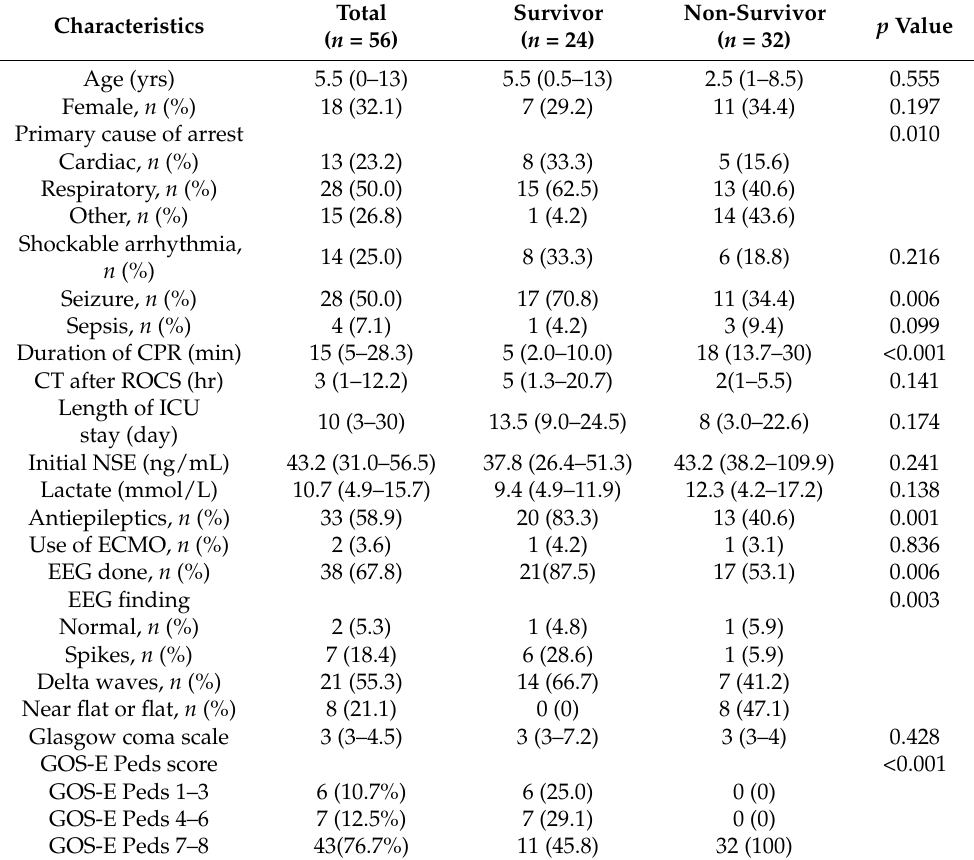
Figure 2. The flowchart of the patients. As described in Table 1, 38 patients were male, and 18 were female. There was no statistical difference between survivors and non-survivors. The median age was 5.5 years (IQR 0–13). Although there was not a significant difference between the ages of survivors and non-survivors, the age of non-survivors tends to be lower (median age 5.5 years vs. 2.5 years). The median age of controls were 10.5 (IQR 3.5–14.0). Table 1. Profiles of study